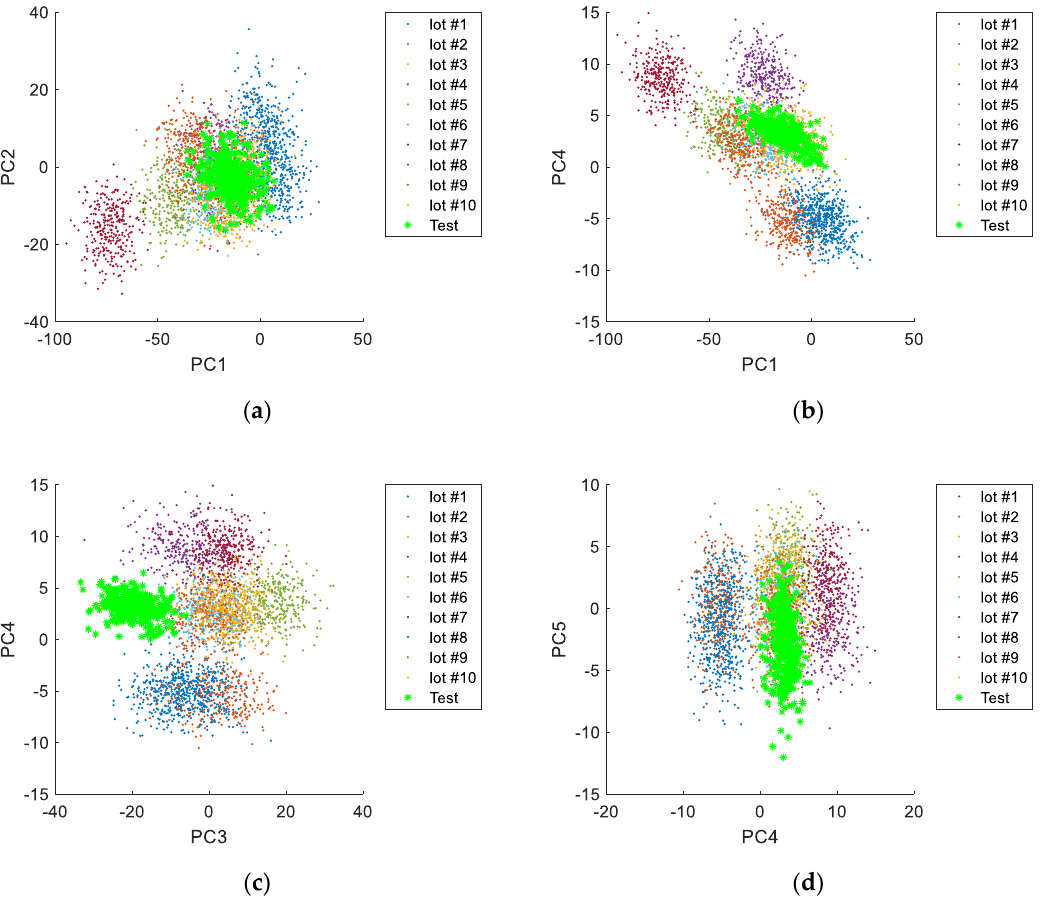
Figure 9. Relation between the principal components of the simulated validation lots and the data Figure 1. ( a ) first and second principal components; ( b ) first and fourth principal components; ( c ) third and fourth principal components; ( d ) fourth and fifth principal components.